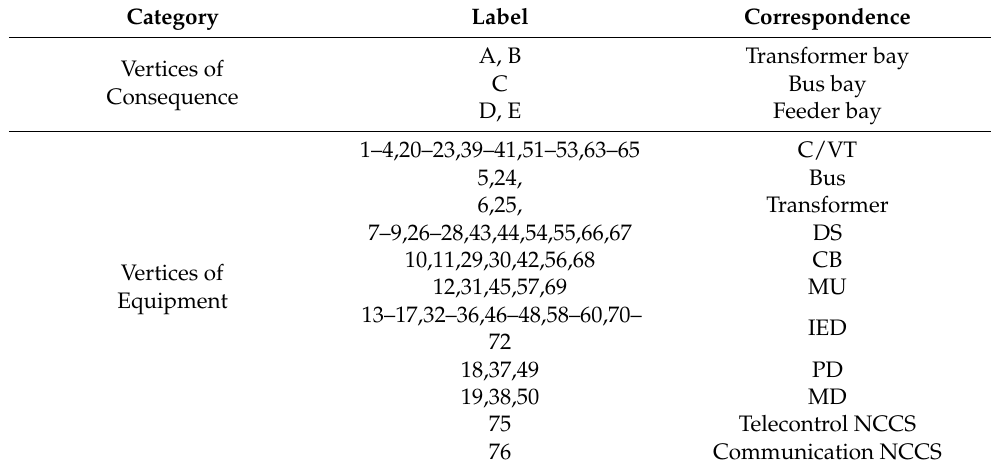
Table 3. The description of vertices in Figure 5.